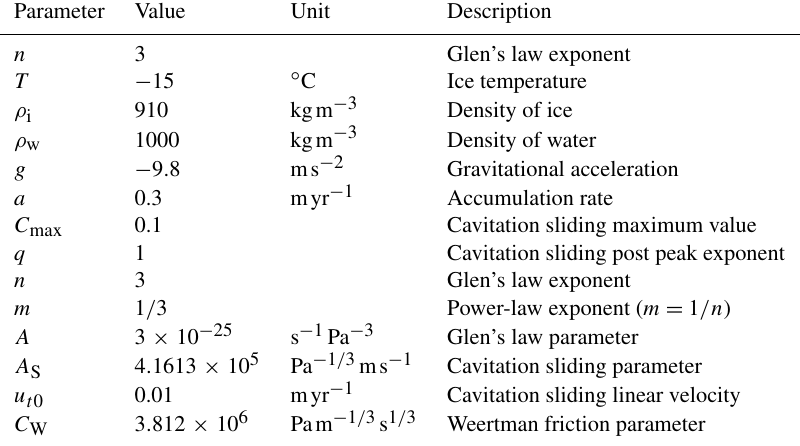
Table B1. Values of model parameters